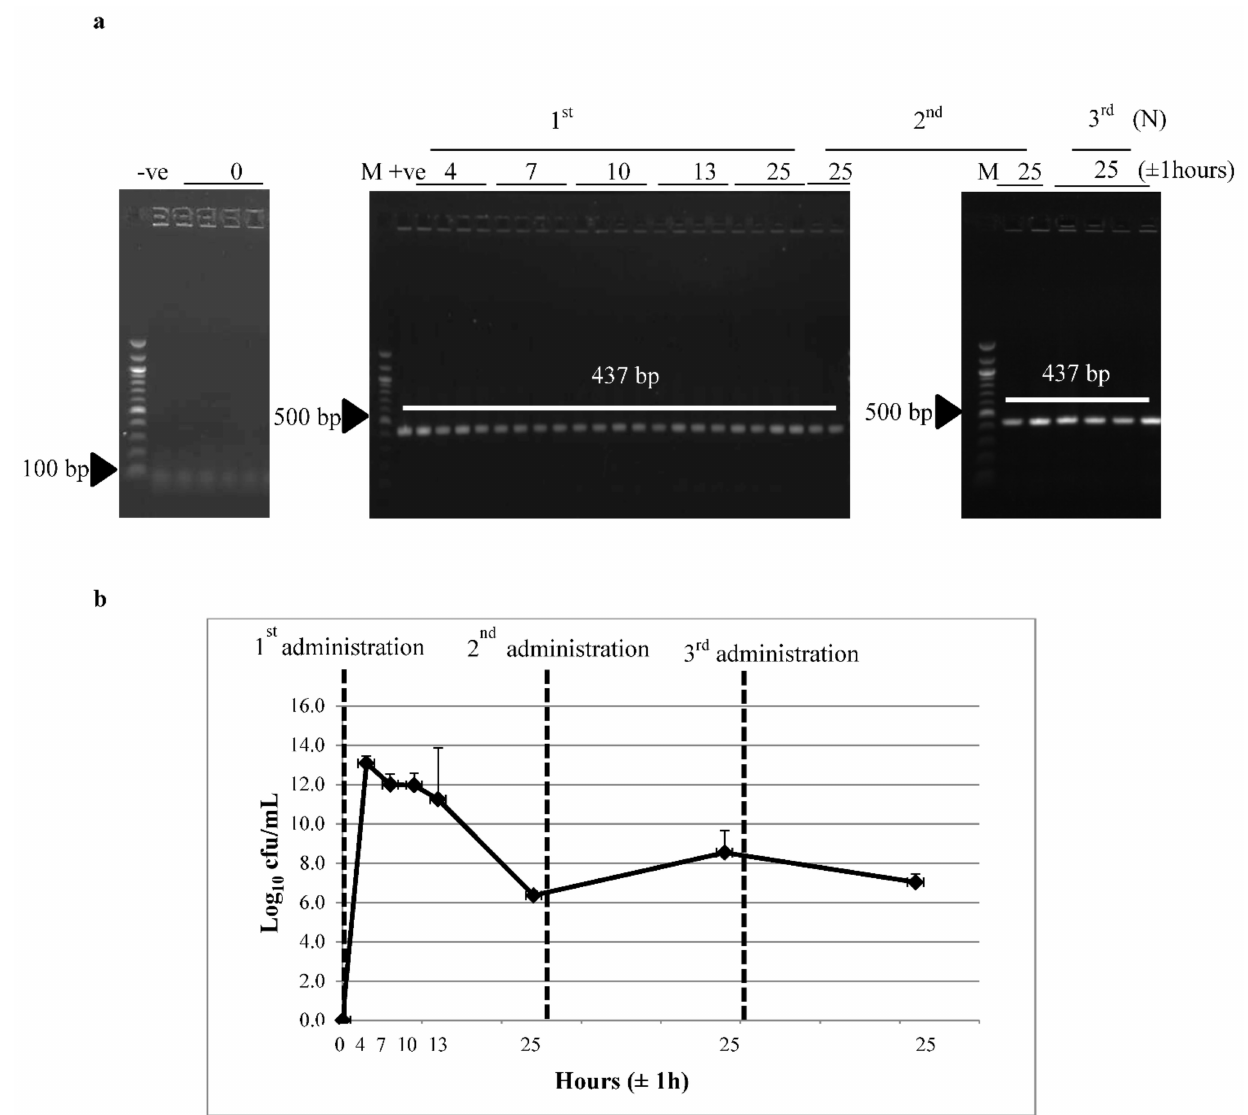
Figure 2. Recombinant L. lactis strain recovered from mice fecal samples before and across different time points after oral administration of L. lactis :pNZ-Usp45-G12A. ( a ) Colony PCR on recovered colonies from orally fed L. lactis :pNZ-Usp45- G12A mice faecal samples. ( b ) Viable counts of chloramphenicol-resistant recombinant L. lactis strain recovered from mice fecal samples across different hours after oral administration. Colony PCR was performed using pNZ8048 vector-specific primers. M: marker; –ve: L. lactis NZ9000; +ve: L. lactis:pNZ-Usp45-G12A. “N” represent the administration number. Results are expressed as log 10 mean ± standard deviation of 4